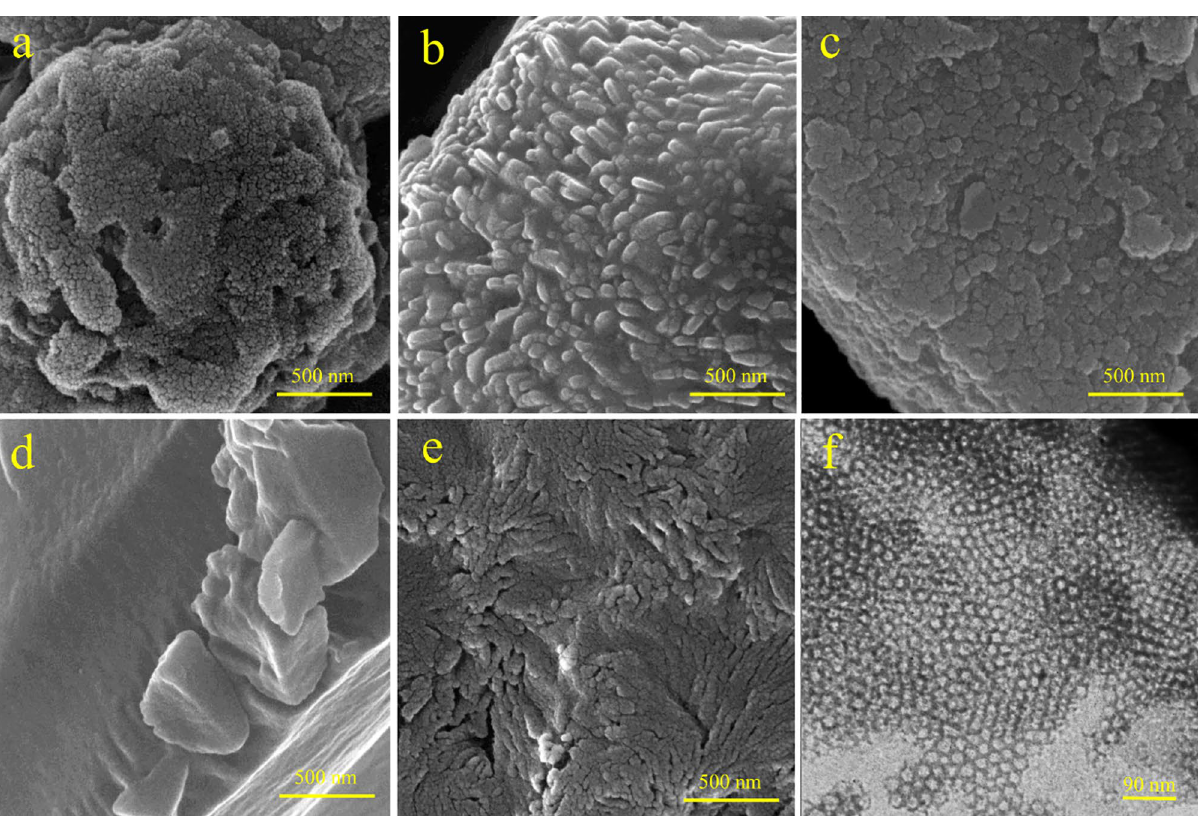
Figure 3. The FE-SEM images of (a) pristine FDU-12, (b) FDU-12-methacrylate, (c) FDU-12-triamine, (d) FDU-12-methacrylate/PMMA, (e) FDU-12-triamine/NY6,6, and (f) TEM image of pristine